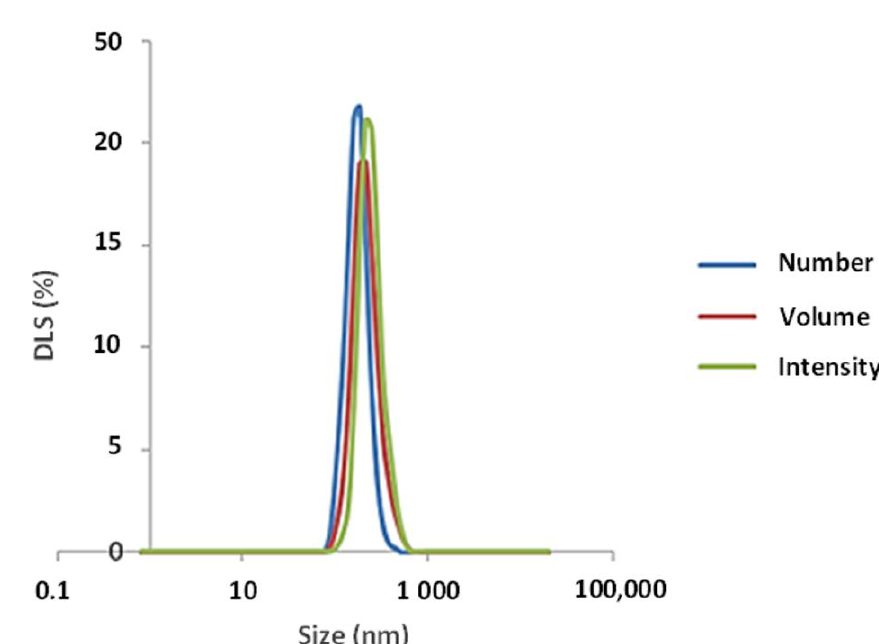
Figure 3. XPS spectra of Ce from CeO 2 -NPs.